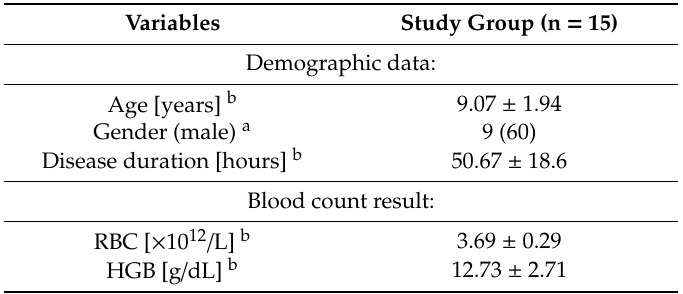
Table 1. Basic data of children with generalized purulent